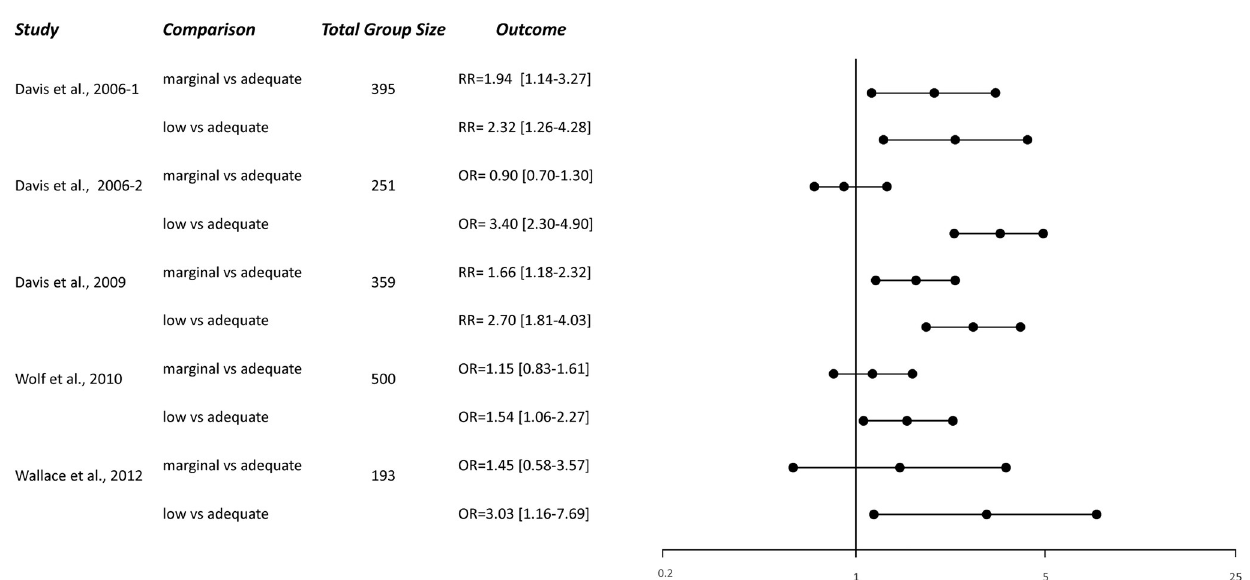
Fig 4. Relative risks and odds ratios of misunderstanding of patients with marginal/low health literacy compared to patients with adequate health literacy.